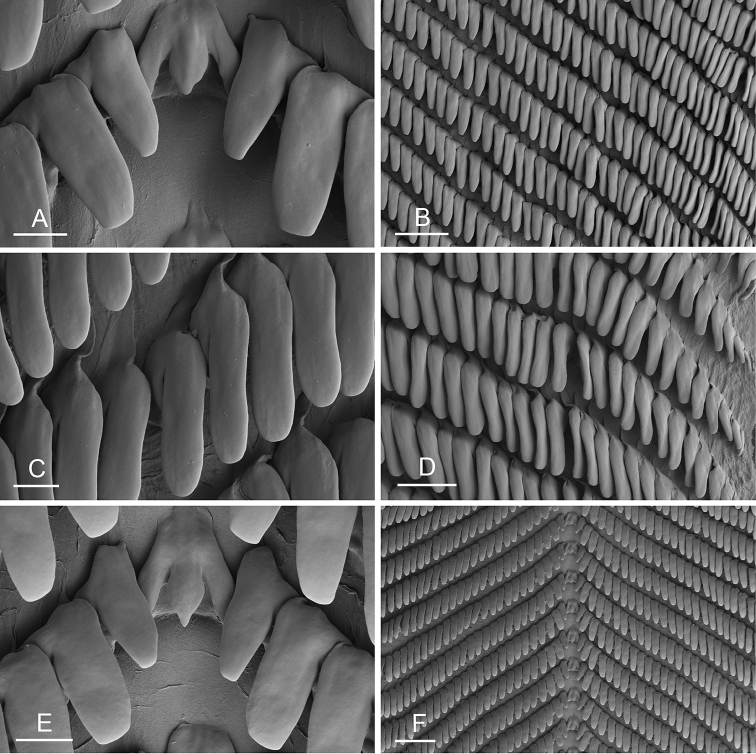
Radula, Peronia
sydneyensis, Australia, New South Wales A–D holotype [1516 H] (AM C.468916.001) E, F [1517] (AM C.468915.001) A rachidian and innermost lateral teeth B lateral teeth C lateral teeth D lateral and outermost lateral teeth E rachidian and innermost lateral teeth F rachidian and lateral teeth. Scale bars: 20 μm (A, C, E), 50 μm (D), 100 μm (B, F).